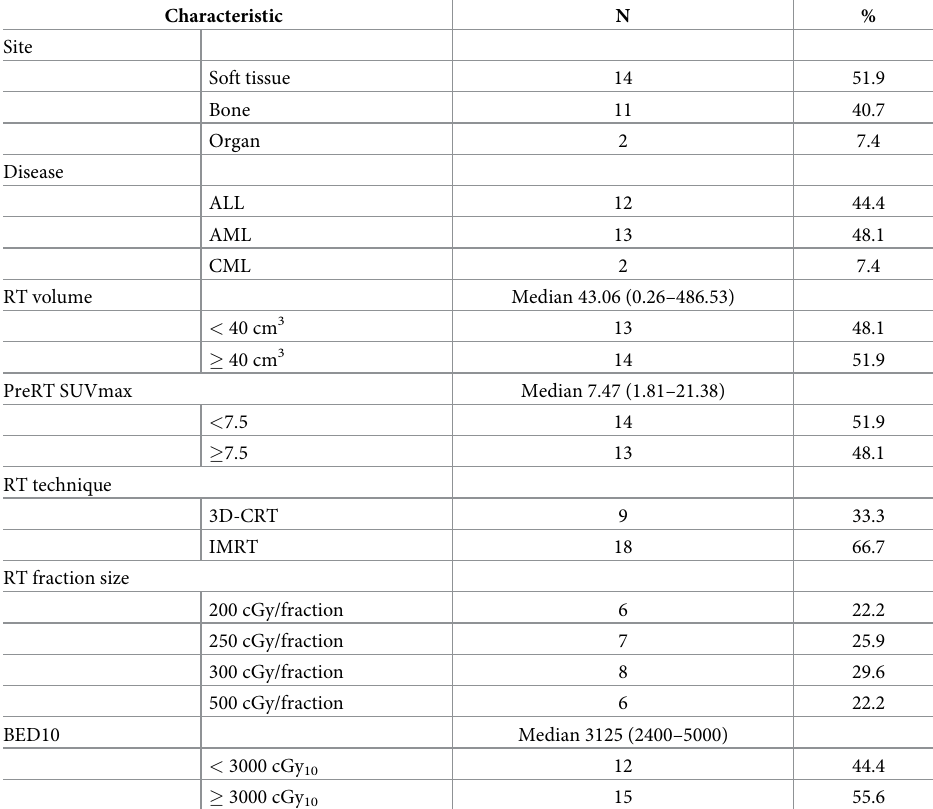
Table 2. Characteristics of the irradiated sites (n =